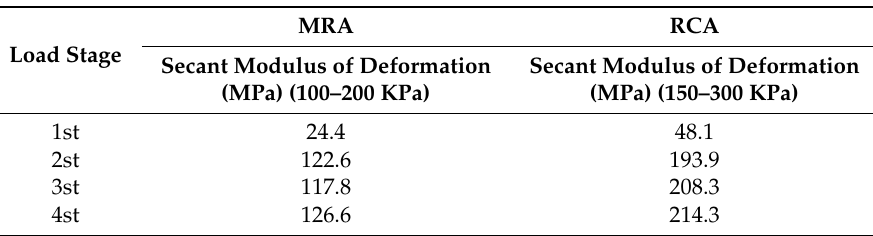
Table 5. Results of experimental triaxial